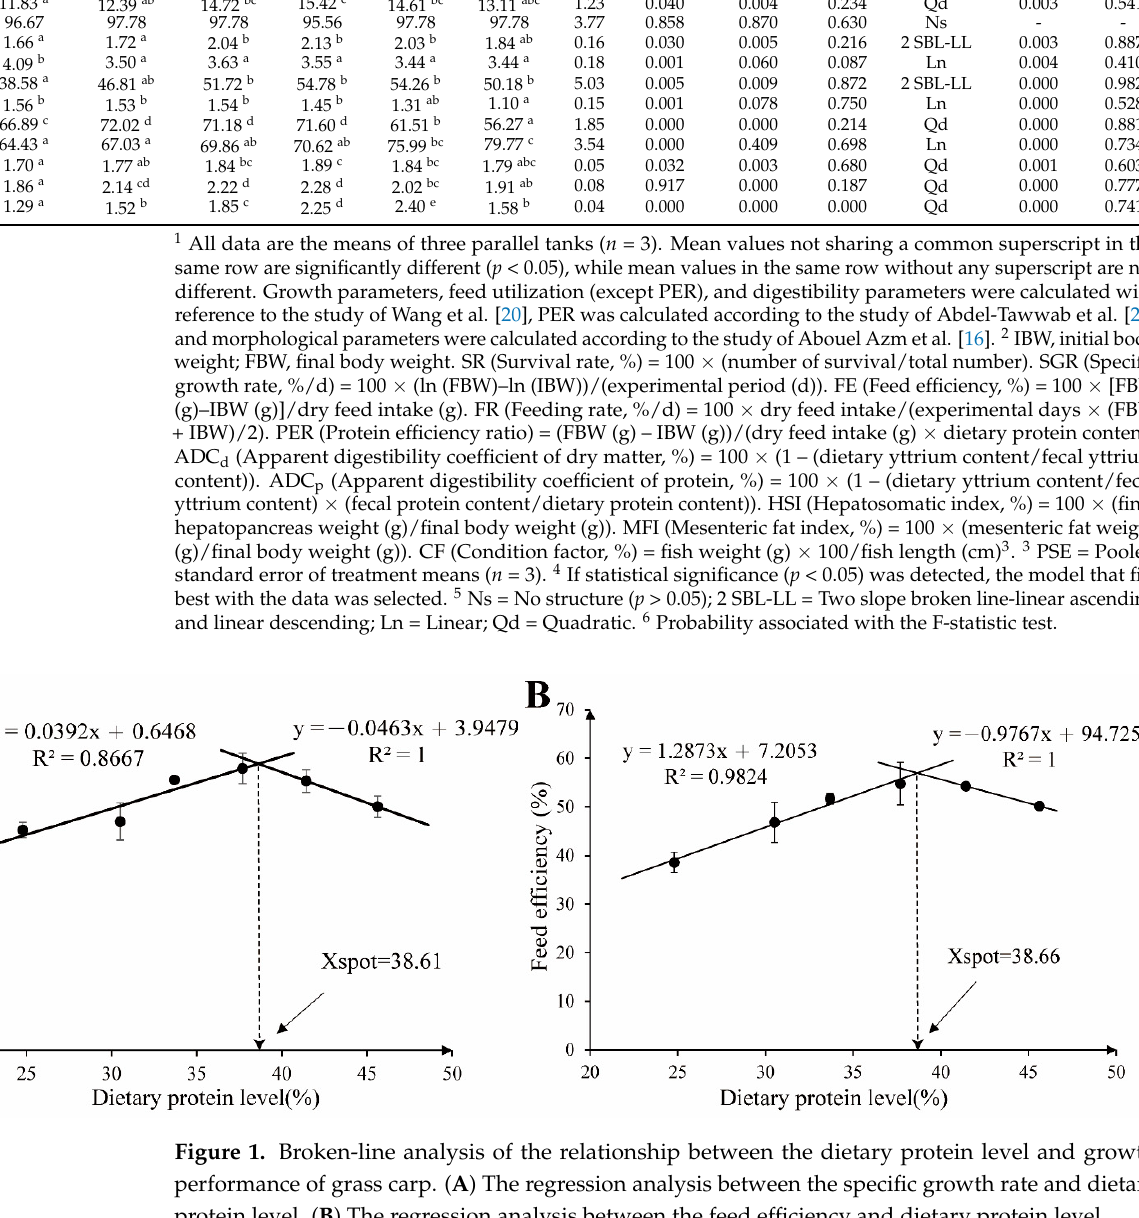
Table 4. Effects of dietary protein levels on the body and dorsal muscle proximate composition of grass carp (% fresh weight) 1 .